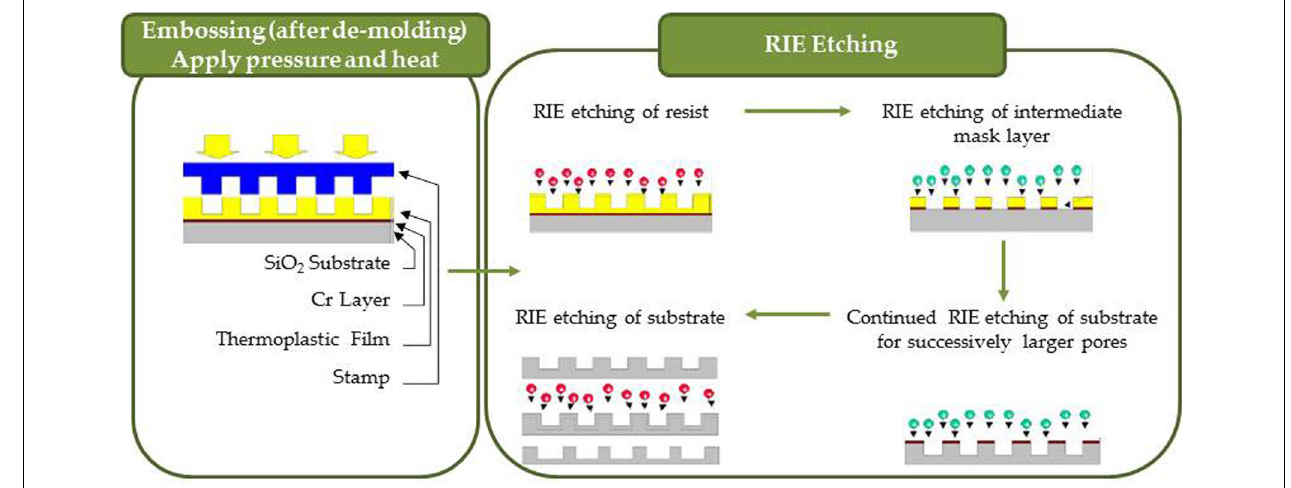
FIGURE 6 | Nanoimprinting process consisting of embossing and RIE etching into resist, intermediate mask layers and substrate.